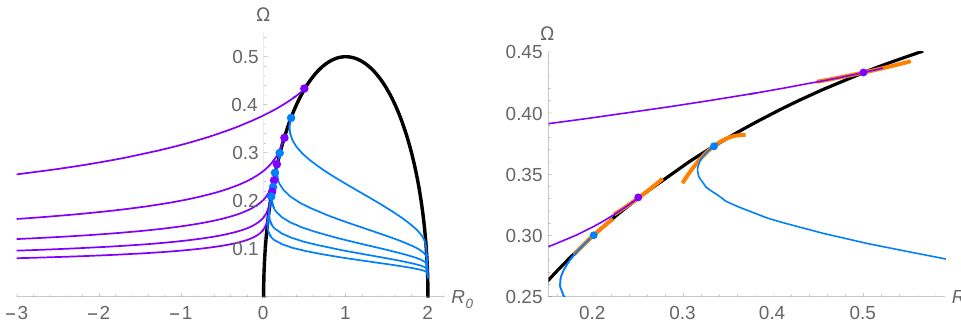
Figure 3 . Branches of axisymmetric deformations (blue) of MP black hole (black) on the ( R 0 ; (cid:10)) plane. Branches moving towards negative R 0 connect to black rings. And have a decreasing mass density at the origin. While the branches moving towards positive R 0 connect to black Saturns and R 0 approaches a value of the stable MP black hole. The right plot is a close-up showing good agreement with the analytic expansions (orange). The right plot also shows the very short ( (cid:0)